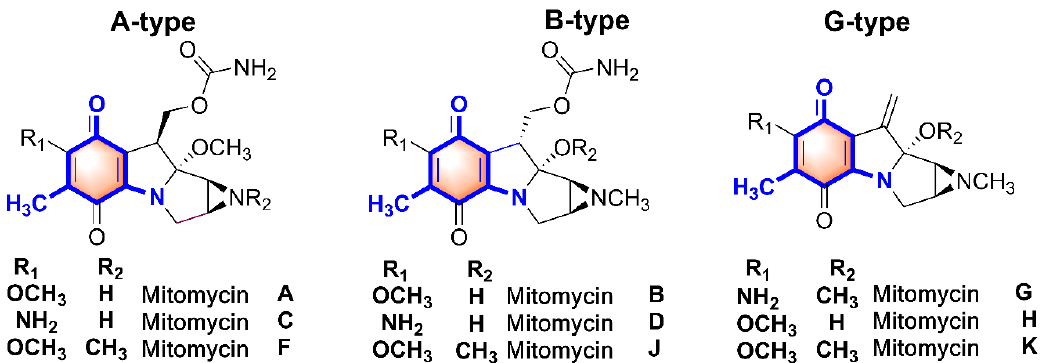
Figure 1. The varied chemical structures of mitomycins.